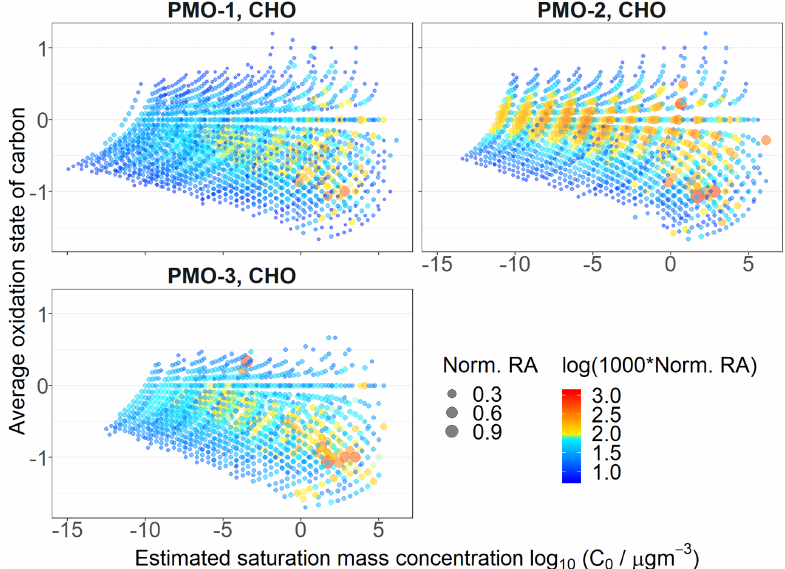
Figure 6. OS C vs. volatility estimated using the Li et al. (2016) method for the CHO species in the three samples. The size is determined by the normalized relative abundance (RA) and the color is determined by the logarithm of the normalized relative abundance multiplied by